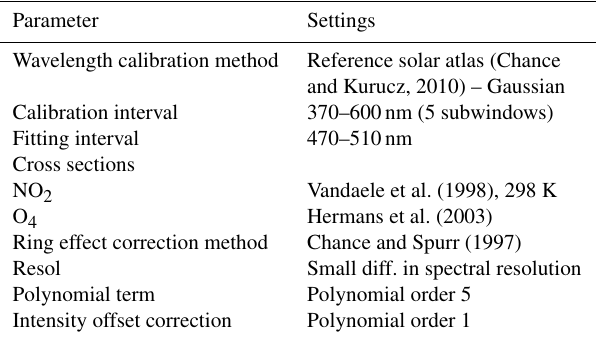
Figure 7. Flow chart of the APEX NO 2 VCD retrieval algorithm. Table 4. Main DOAS spectral fitting analysis parameters for NO 2 slant column